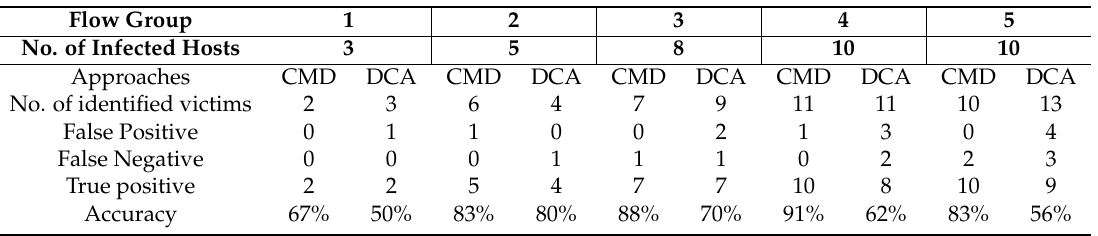
Table 5. Evaluated comparison of the Cascading Motif Discovery-based method and the Destination-source Correlation Algorithm for each flow group under a TCP worm simulated experiment.